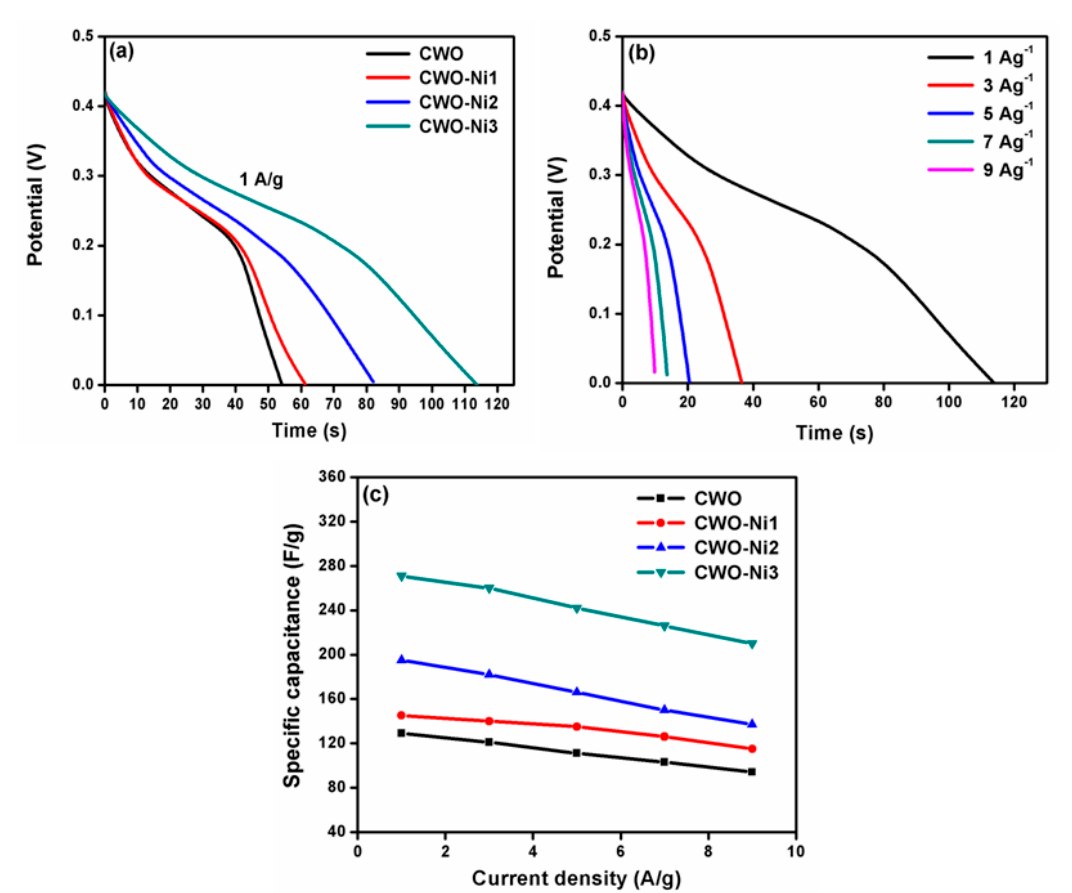
Figure 6. ( a ) Comparison of the charge–discharge (CD) curves of bare CWO, CWO–Ni1, CWO–Ni2, and CWO–Ni3; ( b ) CD plots of CWO–Ni3 at current densities varying from 1 to 9 A g − 1 ; ( c ) comparison of the SC values of CWO, CWO–ONi1, CWO–Ni2, and CWO–Ni3 at different scan current densities.